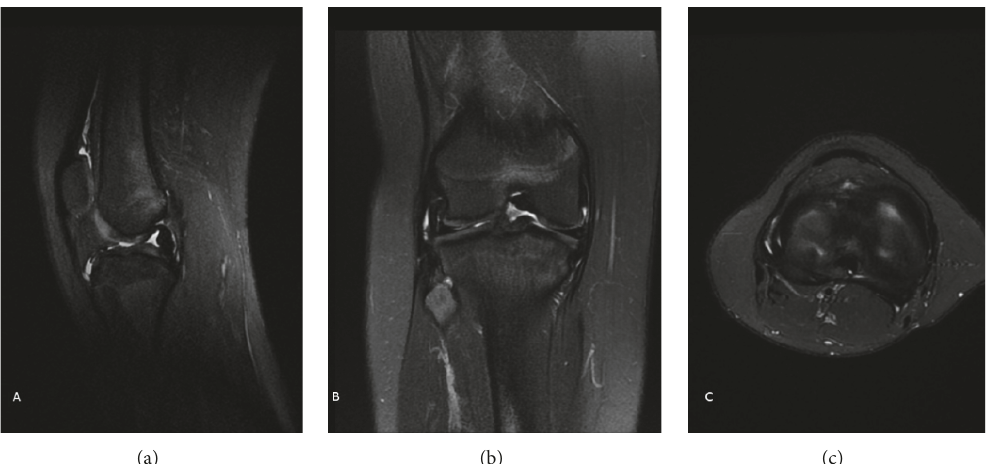
Figure 6: MRI (sagittal (a), coronal (b), and transverse (c) views) of the right knee of a 15-year-old female patient shows complete agenesis of the ACL and a normal PCL.